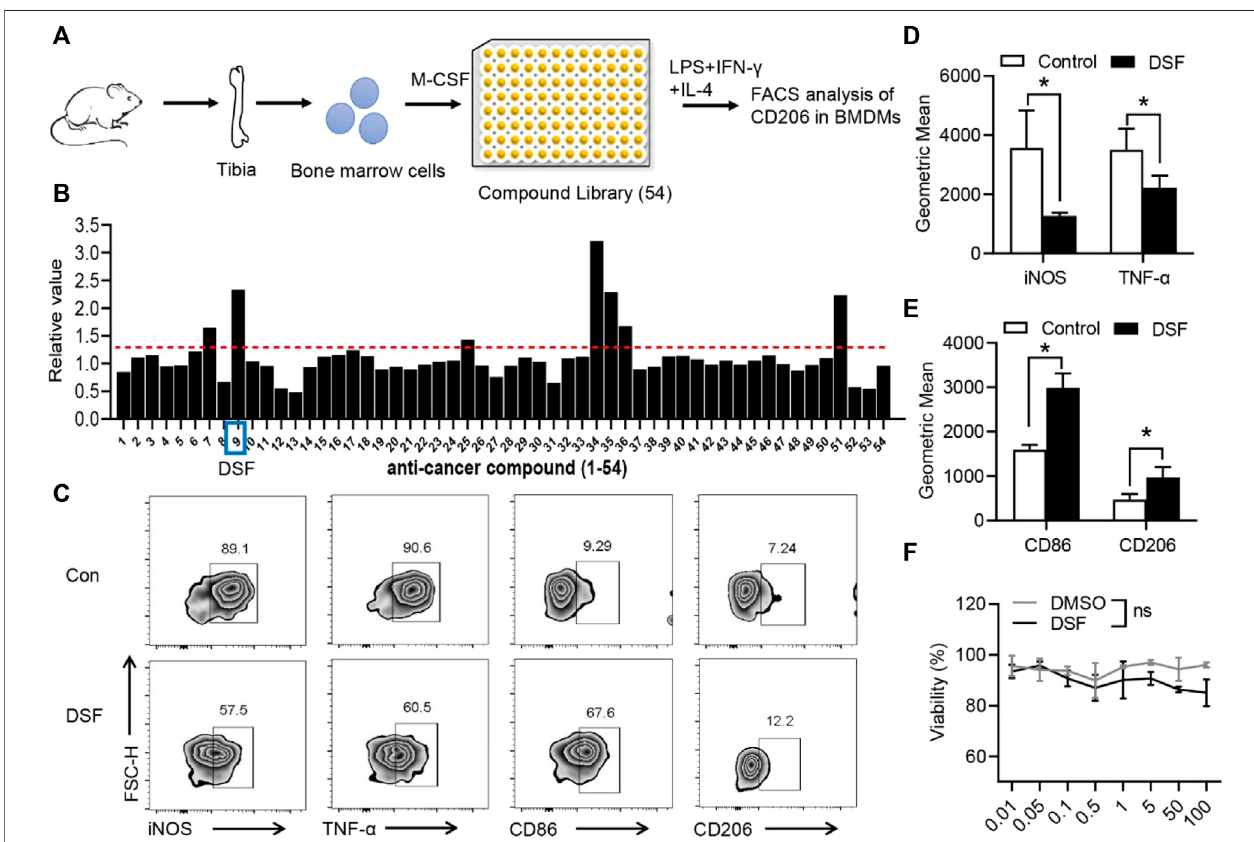
FIGURE 2 | DSF signi fi cantly promotes pro-in fl ammatory macrophages into the M2-type phenotype. (A) The diagram of screening assay. Bone marrow cells were isolated from the tibia of wild-type mice. BMDMs were induced by M-CSF (50 ng/ml). Then the cells were treated with LPS (100 ng/ml), IFN- γ (20 ng/ ml), and IL-4 (20 ng/ml) for 6 h and underwent FACS analysis of CD206 expression. (B) Quantitative analysis of the candidates in screening assay. (C) BMDMs were pretreated with DSF (5 μ M) or DMSO (0.01%). Then the cells were treated with LPS (100 ng/ml), IFN- γ (20 ng/ml), and IL-4 (20 ng/ml) for 6 h. FACS analysis of iNOS, TNF- α , CD86, and CD206. (D,E) Quantitative analysis of geometric mean of iNOS (D) TNF- α (D) , CD86 (E) and CD206 (E) . (F) CCK-8 analysis of BMDMs after treatment with DSF at different dosages. Data are presented as the mean ± SEM ( n = 3) (D , E , F) . * p < 0.05.